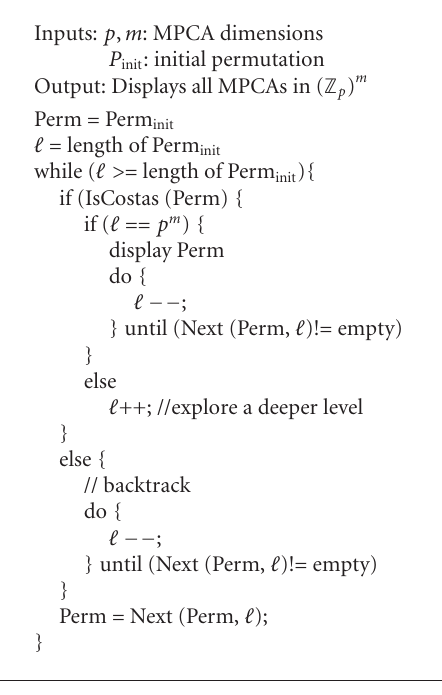
Algorithm 1: Backtracking algorithm to enumerate all MPCAs in ( Z p ) m beginning with permutation Perm init .